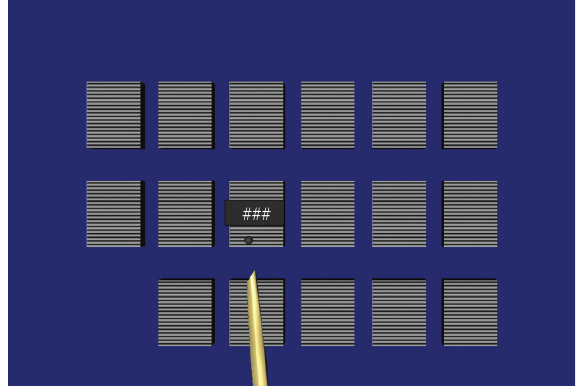
Figure 4: An example of experiment 3: as participants touched the cube and presses it a bit inwards, they felt haptically if it was a hard or a soft cube. Simultaneously with the haptic sensation, a (congruent, neutral or incongruent) label appeared on the cube. After a judgment was given for a cube it disappeared from the